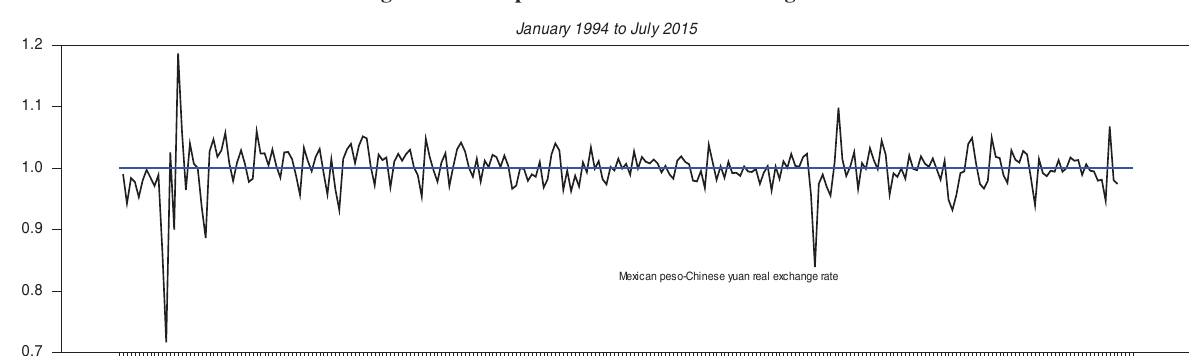
Fig. 5. Mexican peso-U.S. dollar real exchange rate